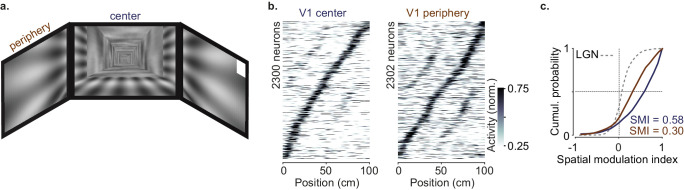
Neurons with central receptive fields showed stronger spatial modulation than neurons with peripheral receptive fields due to the layout of the visual scenes.(a) Cartoon of the virtual reality scenes layout. (b) Response profile patterns obtained from even trials (ordered and normalized based on odd trials) for portions of V1 with average receptive fields in the center (‘V1 center’;<40° azimuth angle; left) or in the periphery (‘V1 periphery’; right). (c) Cumulative distribution of the spatial modulation index in even trials for ‘V1 center’ (purple) or ‘V1 periphery’ (orange); dotted line: Distribution of lateral geniculate nucleus (LGN) boutons (same as in Figure 2d).